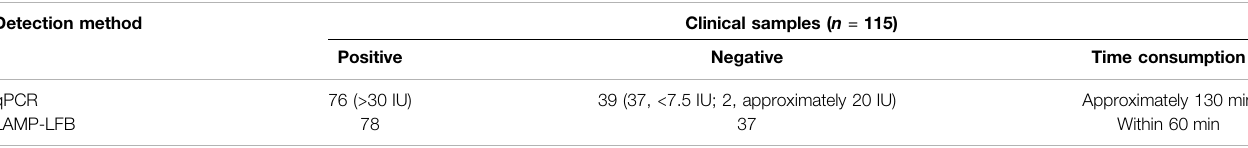
TABLE 3 | Comparison of qPCR and LAMP-LFB methods to identify HBV in clinical samples. Detection